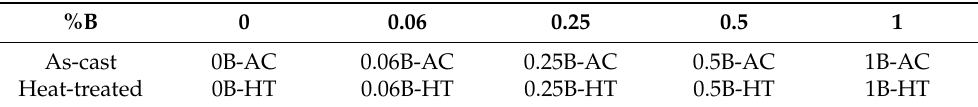
Table 2. Identification of